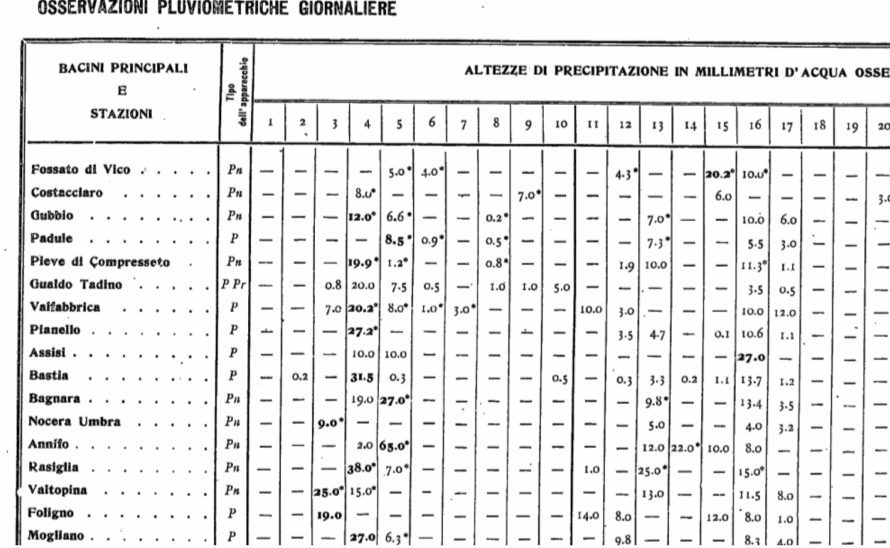
Figure 3. Transcription of manual recording of daily rainfall data during two decades of January 1922 for some rain gauge stations located in central Italy.